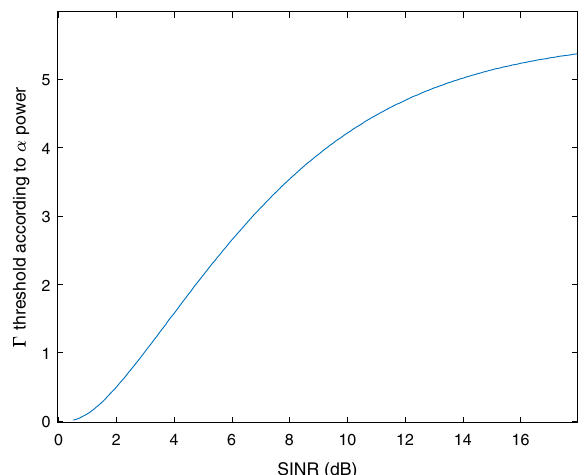
Fig. 10 Ŵ value depends on SINR to have the same complexity between HIC-MPA and MUD when SNR 4 =